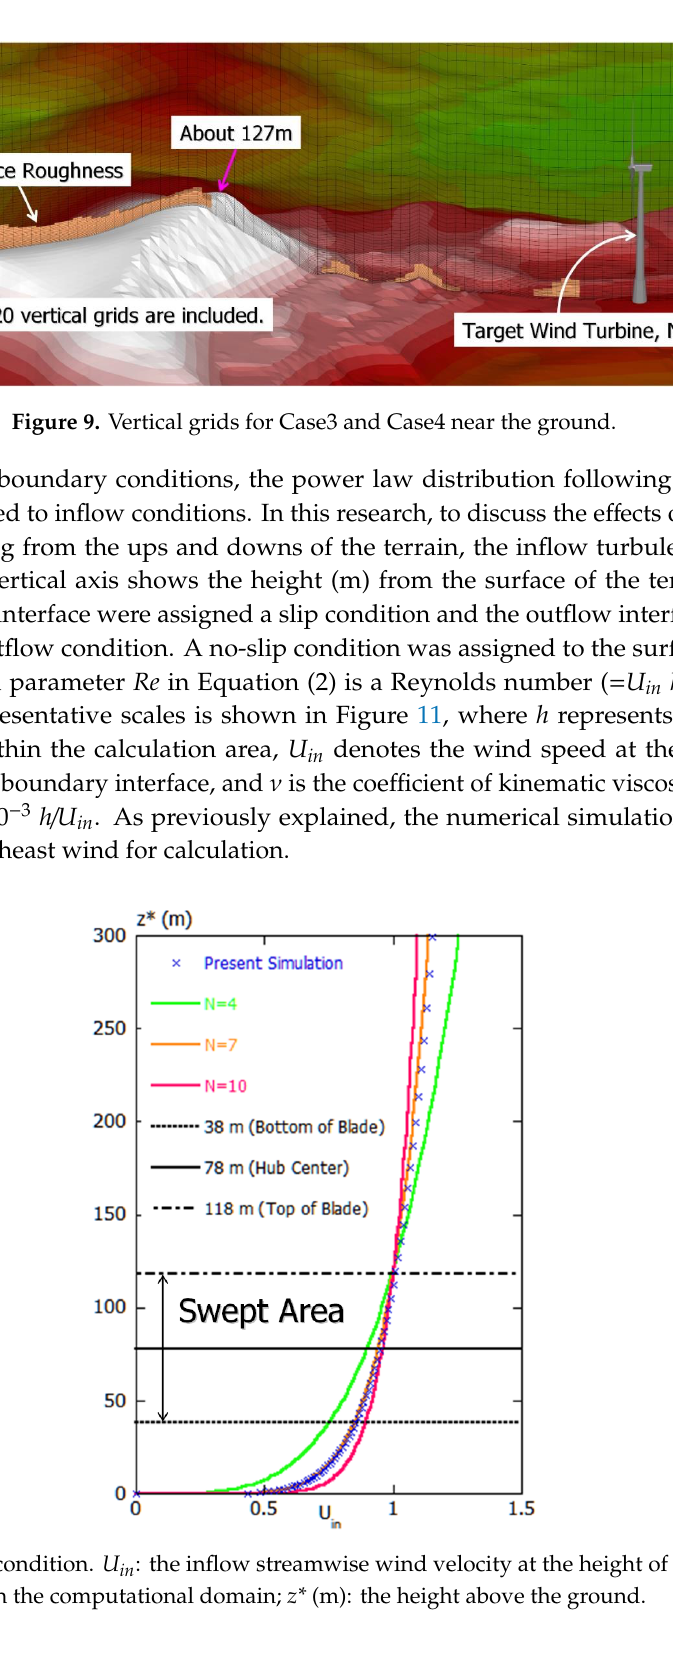
Figure 8. Computational grids for ( a ) Case1 and ( b ) Case2, Case3, and Case4.